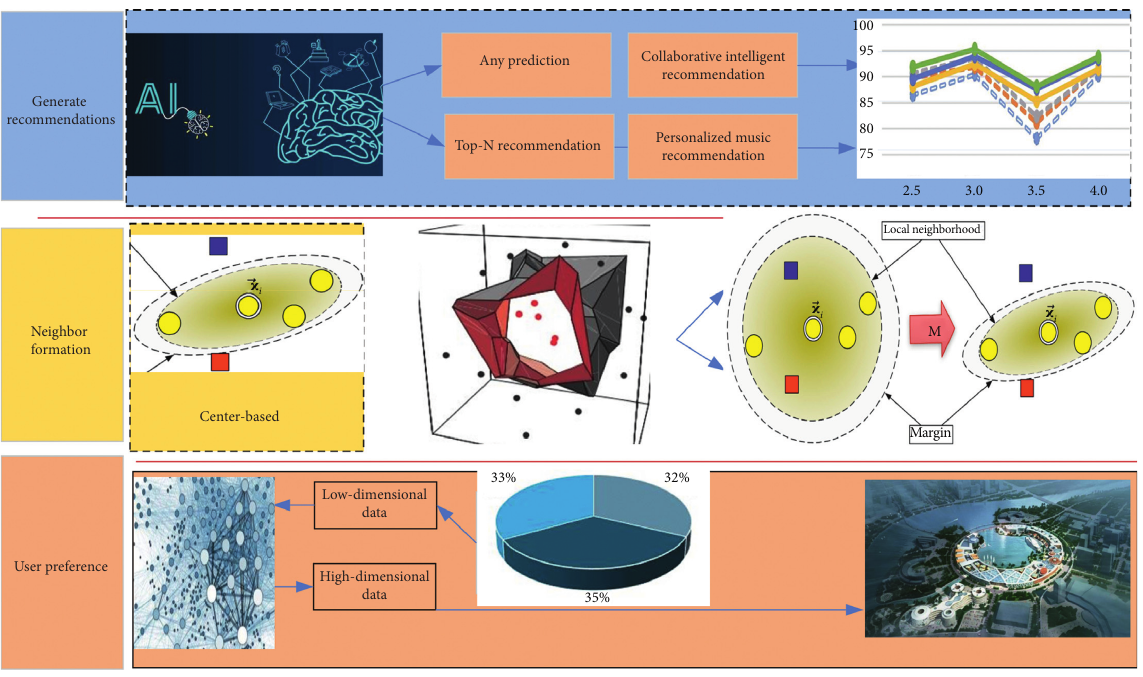
Figure 3: Collaborative filtering music recommendation. Table 1: User project evaluation